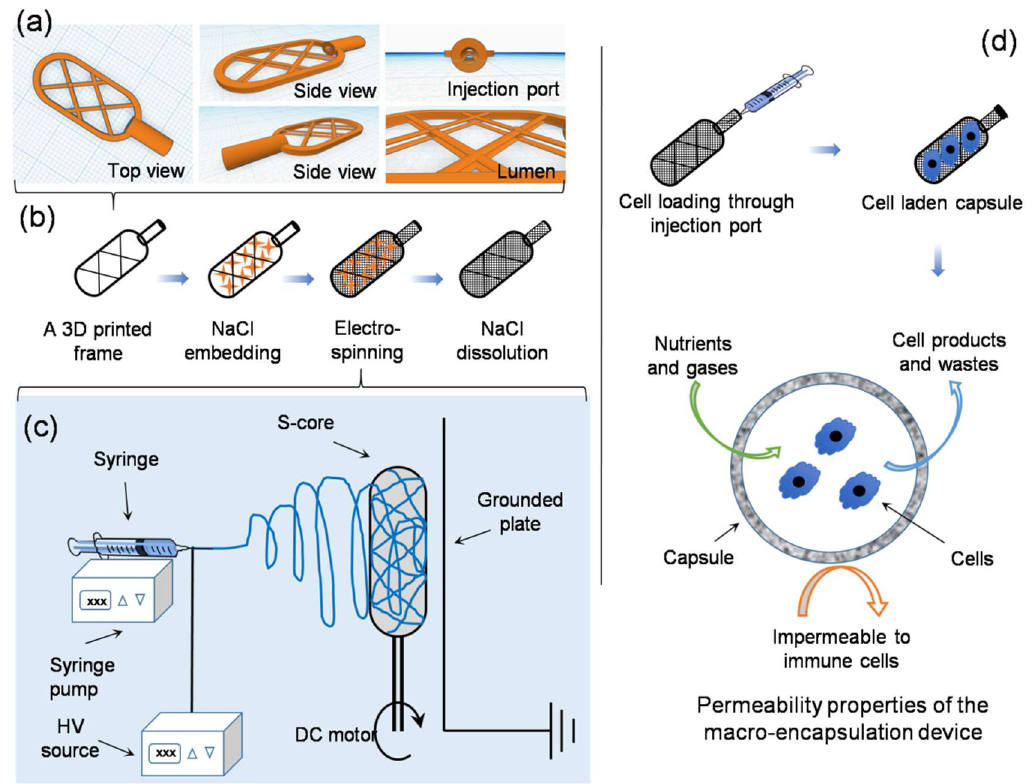
Figure 1. Schematic showing sacrificial core electrospinning capsule fabrication and use: ( a ) Images show the CAD 3D model of the supporting framework (frame). ( b ) Work flow showing the steps involved in device assembly, detailing supporting framework production, salt embedding, electrospinning and salt dissolution. ( c ) Electrospinning setup, highlighting how the salt aggregate contacting supporting frame was placed directly in front of the grounded collecting plate and rotated during fiber collection. ( d ) Loading of the electrospun capsule with cells for use in cell and tissue encapsulation applications, highlighting how the capsule allows free diffusion on nutrients, gases, cellular products and waste, whilst blocking access to immune cell penetration.